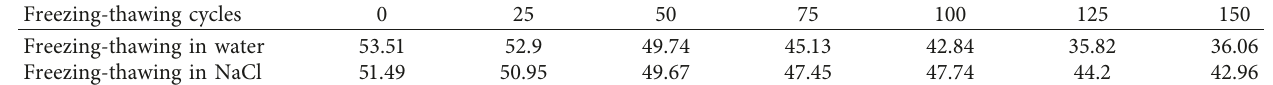
Table 5: Dynamic elastic modulus of the test beam after freezing and melting.